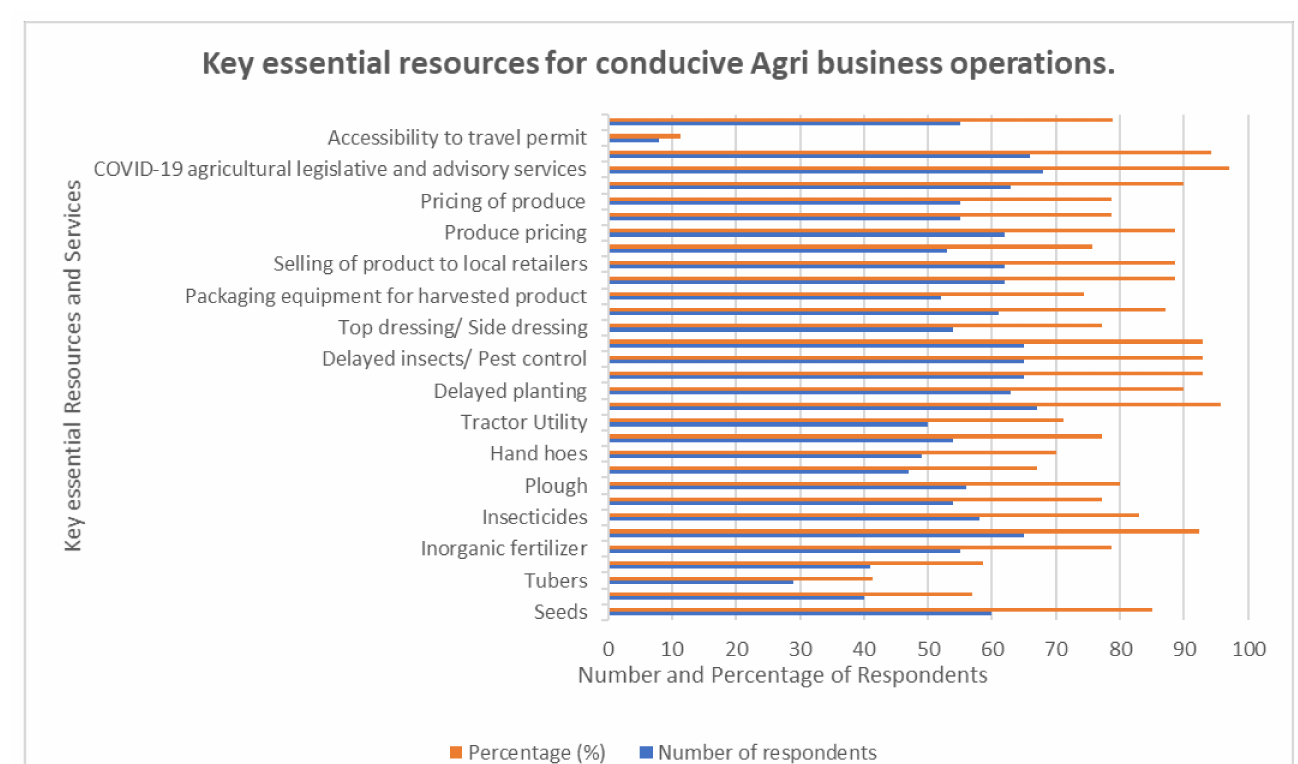
Figure 4. Key essential resources for conducive agribusiness